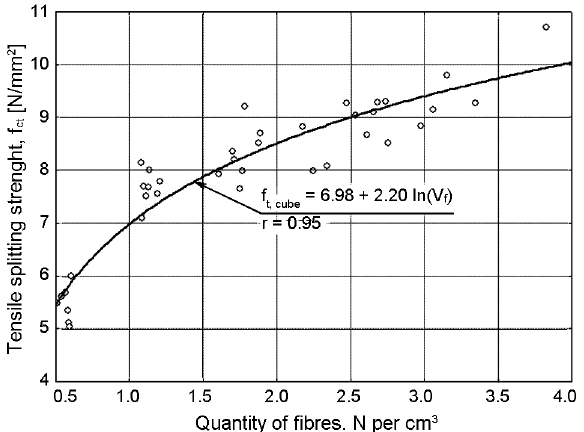
Fig. 8. The dependence of the split tensile strength of the